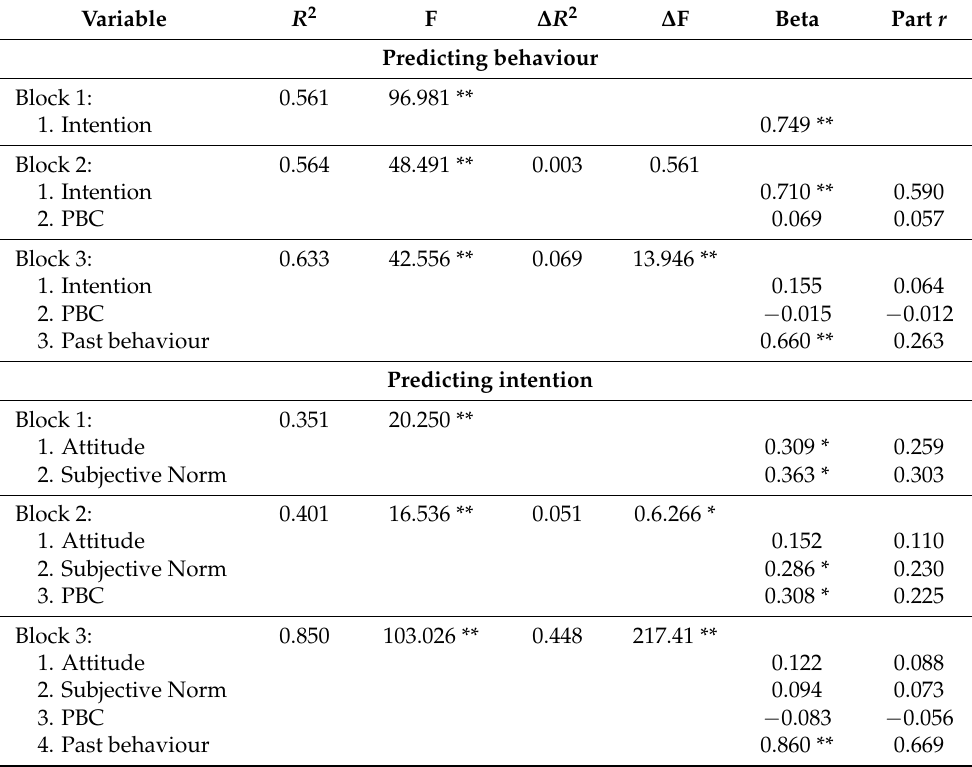
Table 9. HRA for TPB with past behaviour as an additional